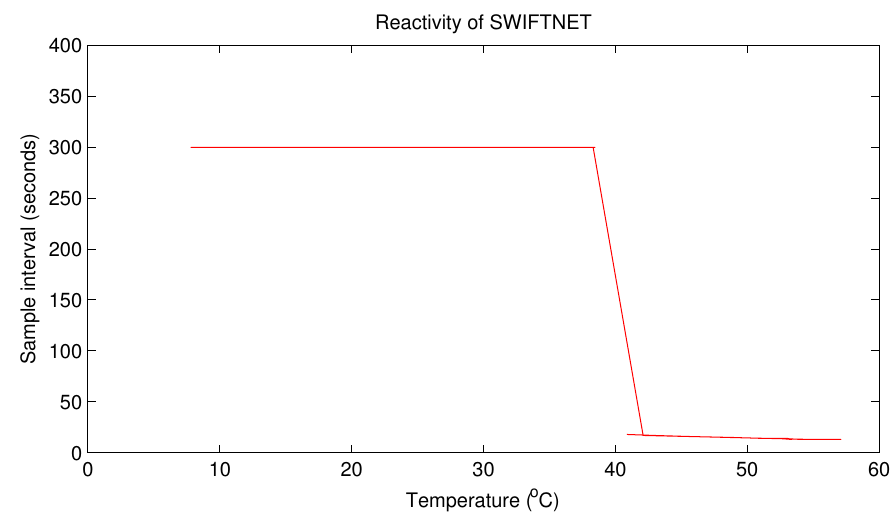
Figure 10. Dynamic sampling interval of